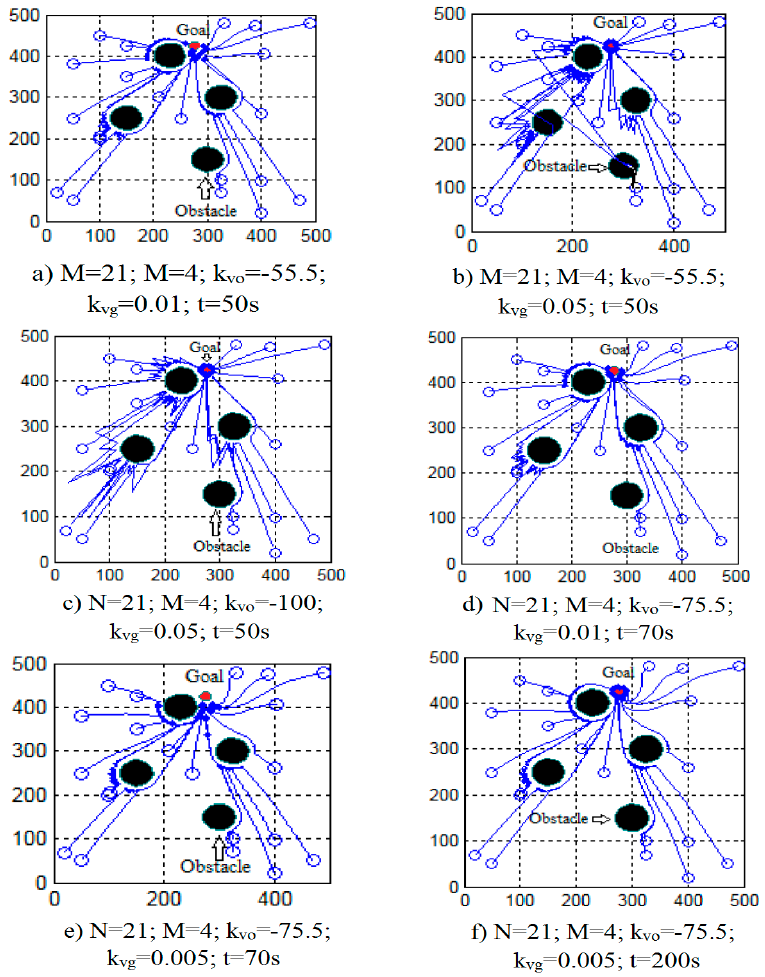
Figure 7. The simulation results of the multitask process when the coefficients k vo and k vg are changing.